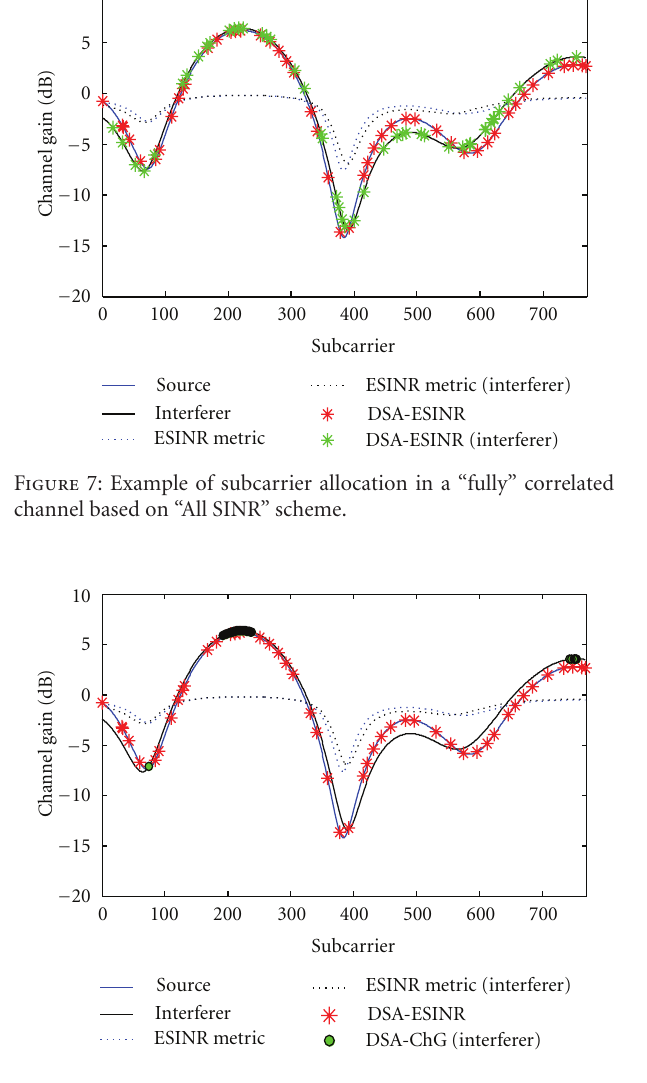
Figure 8: Example of subcarrier allocation in a “fully” correlated channel based on “Partial SINR” scheme.